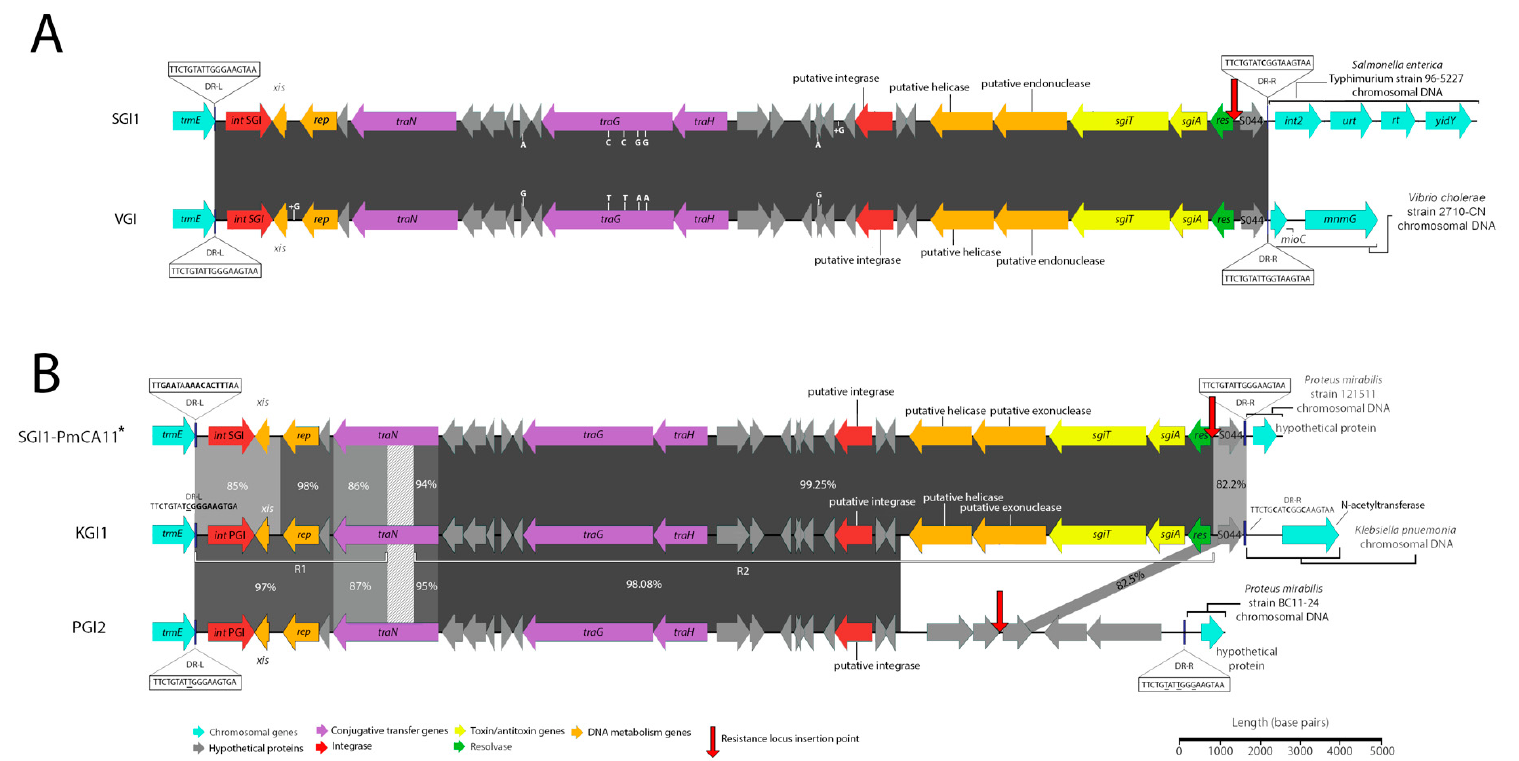
Figure 1. Schematic representation of Salmonella genomic island 1-related elements (SGI1-REs) identified in this investigation that are void of integrons. Scale is approximate. Closely related SGI1-REs from public databases are shown atop and below to allow visualization of the nucleotide identity across the novel elements and the references. Nucleotide identities of trmE genes (not shown) did not exceed greater than 75% for Vibrio genomic island (VGI) or Klebsiella genomic island (KGI) in comparison with the trmE genes of other sequences represented in this schematic. ( A ) A comparison of SGI1 (Accession No: AF261825) shown atop VGI (Accession No. MN708015). Identities and locations of single nucleotide polymorphisms are indicated atop vertical lines at the top and bottom of either element, while nucleotide insertions are indicated in the same fashion but denoted with a plus symbol ( + ). Genetic context inferred from S. Typhimurium DT104 (GenBank accession number HF937208). ( B ) A comparison of KGI (Accession No. MN708012), PGI2 (Accession No. MG201402) and SGI1-PmCA11 (Accession No. MH990673). Due to the lower nucleotide identity matching between these structures the locations and identities of mismatches and indels are not indicated for ease of interpretation. SGI1-PmCA11*: genetic context inferred from Xiao et al (2019) [16].